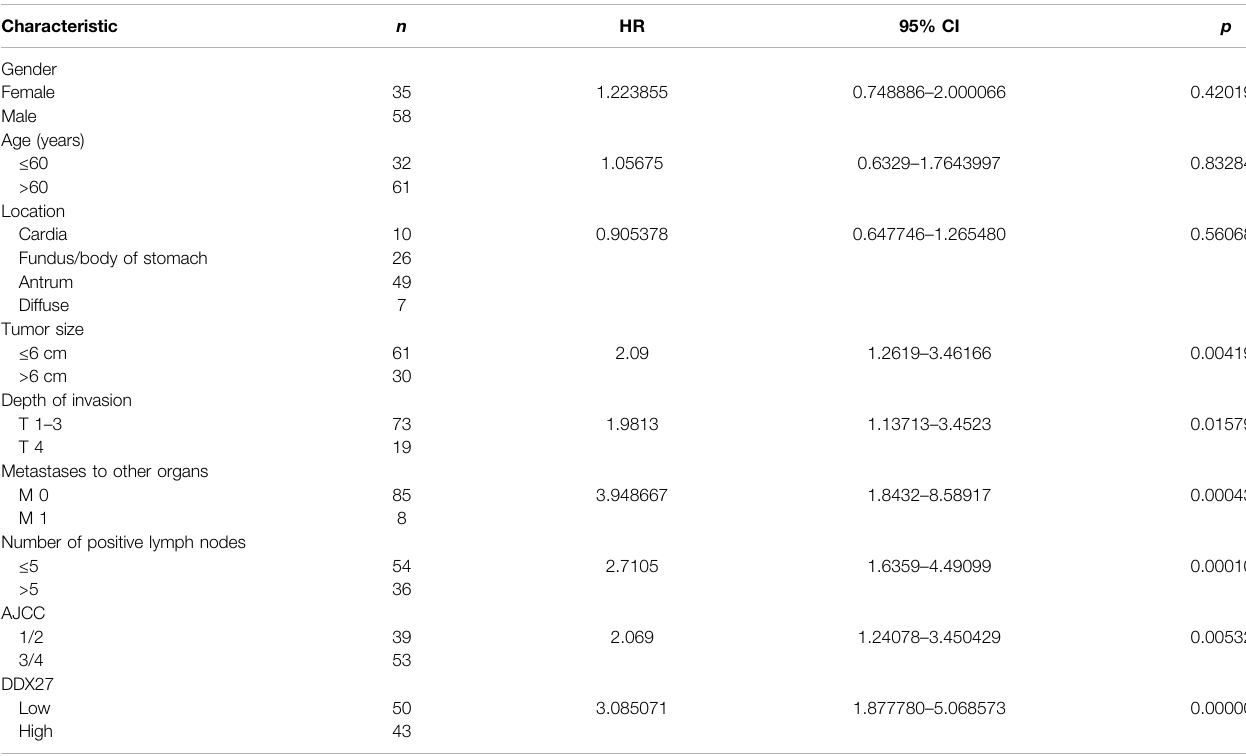
PS: bold fonts represent p <